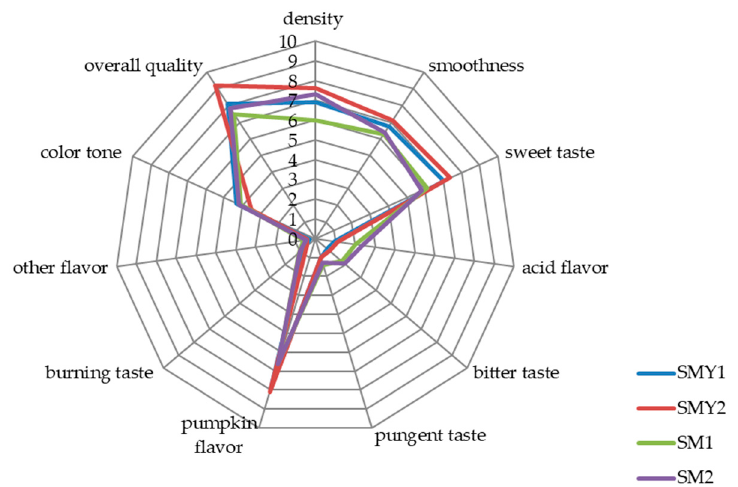
Figure 3. Sensory profile of functional frozen desserts manufactured by using different pumpkin cultivars. Explanatory notes: The presented samples are coded according to Section 2; Table 1.